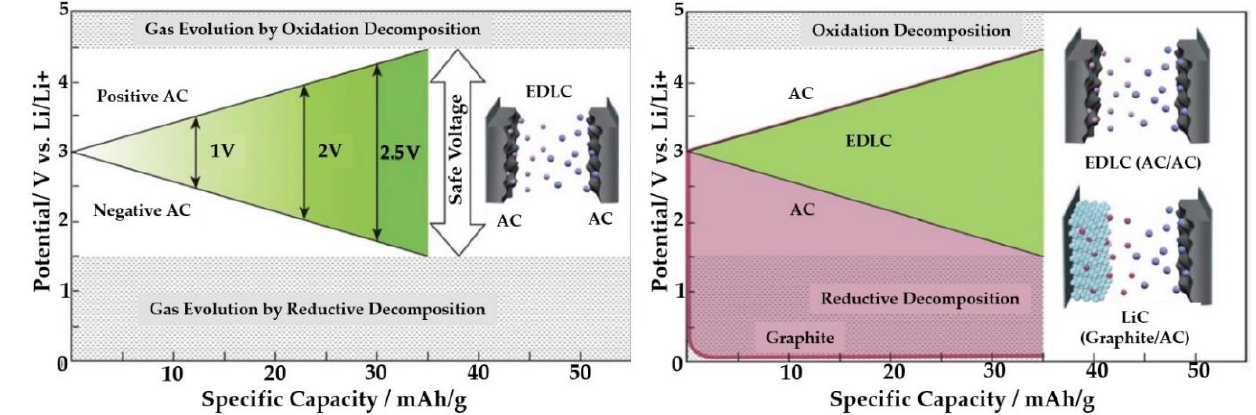
Figure 6. The potential comparison between EDLCs and LiCs